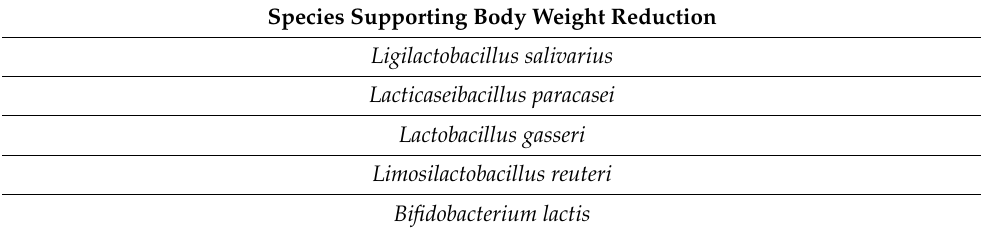
Table 2. The probiotic species beneficial for body weight